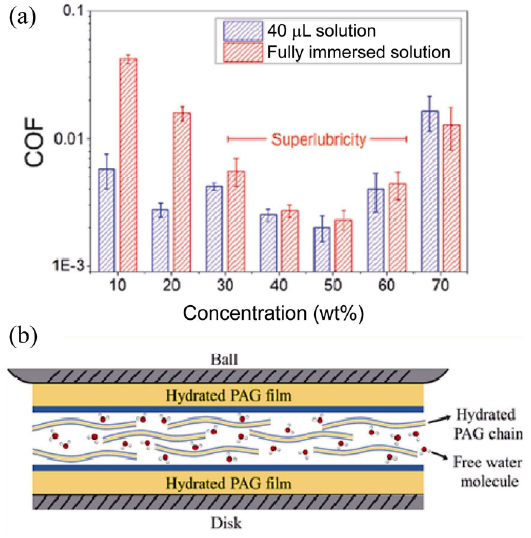
Fig. 10 (a) Final COF of 40 μ L and fully immersed PAG aqueous solutions (weight fraction from 10 wt% to 70 wt%). Superlubricity is achieved over a range of concentrations from 30 wt% to 60 wt%. (b) Schematic of the proposed lubrication model between two sliding surfaces. Reproduced with permission from Ref. [40], © WILEY-VCH Verlag GmbH & Co. KGaA Weinheim